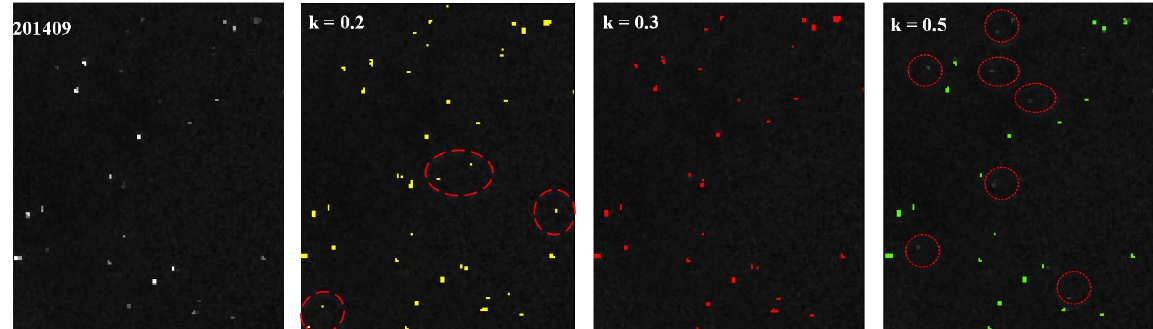
Figure 5. The segmentation effect of Sauvola algorithm using different k.